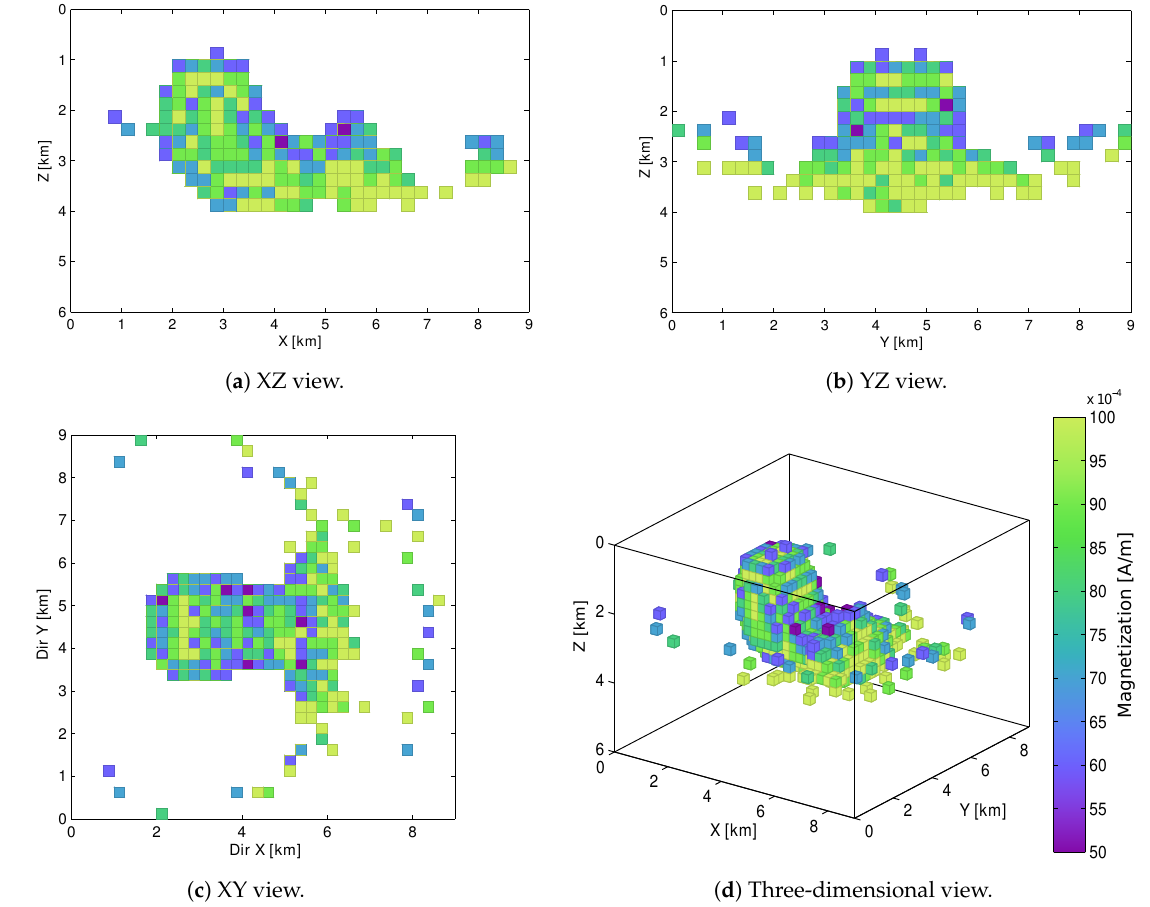
Figure 22. Inverted magnetic S model.